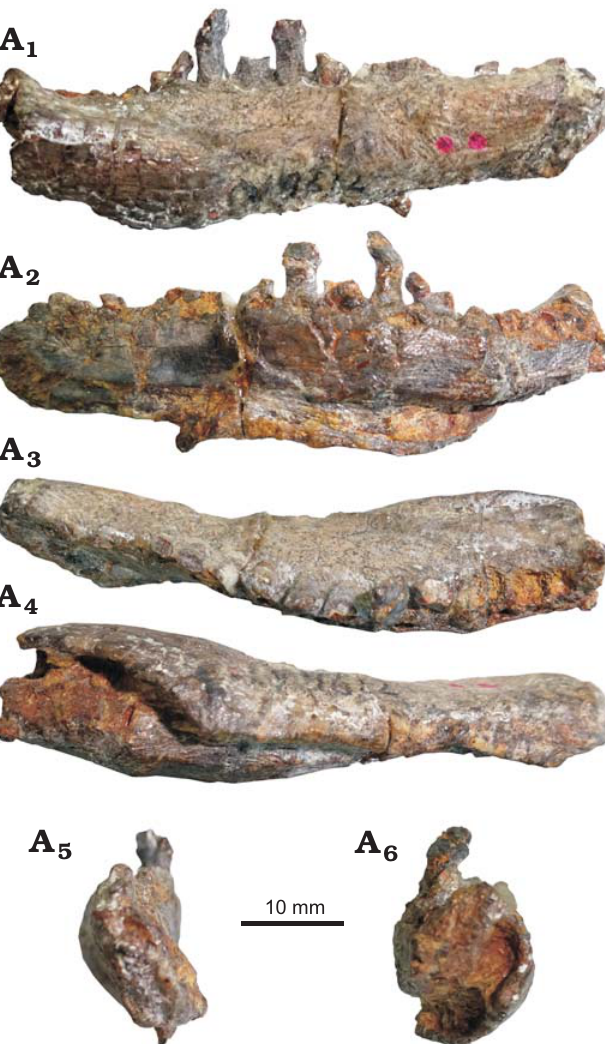
Fig. 1. Thyreophoran dinosaur Bienosaurus lufengensis Dong, 2001 (IVPP V15311, holotype), from the Hettangian–Sinemurian (Lower Jurassic), Lower Lufeng Formation of Yunnan, China; partial right dentary in lateral (A 1 ), medial (A 2 ), dorsal (A 3 ), ventral (A 4 ), anterior (A 5 ), and posterior (A 6 )